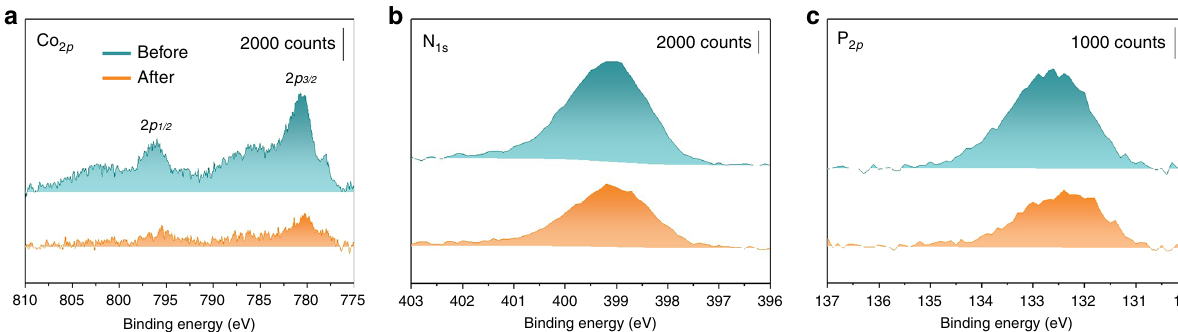
Fig. 3 XPS analysis of the Co-qPyH|m-TiO 2 electrode. Before (blue trace) and after (orange trace) 2 h of electrolysis at − 0.51 V vs. RHE in 0.1 M KHCO 3 electrolyte saturated with CO 2 (pH = 6.8). Data show binding energies for Co 2p ( a ), N 1s ( b ), and P 2p ( c ).